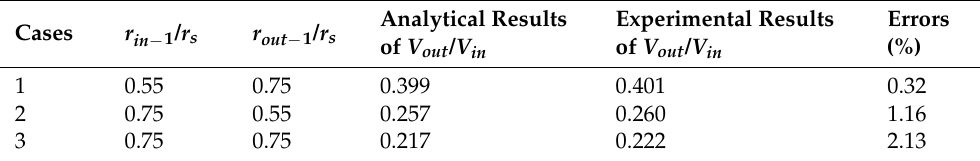
Table 3. The comparison of analytical solutions and measurement results with different radius ratio.